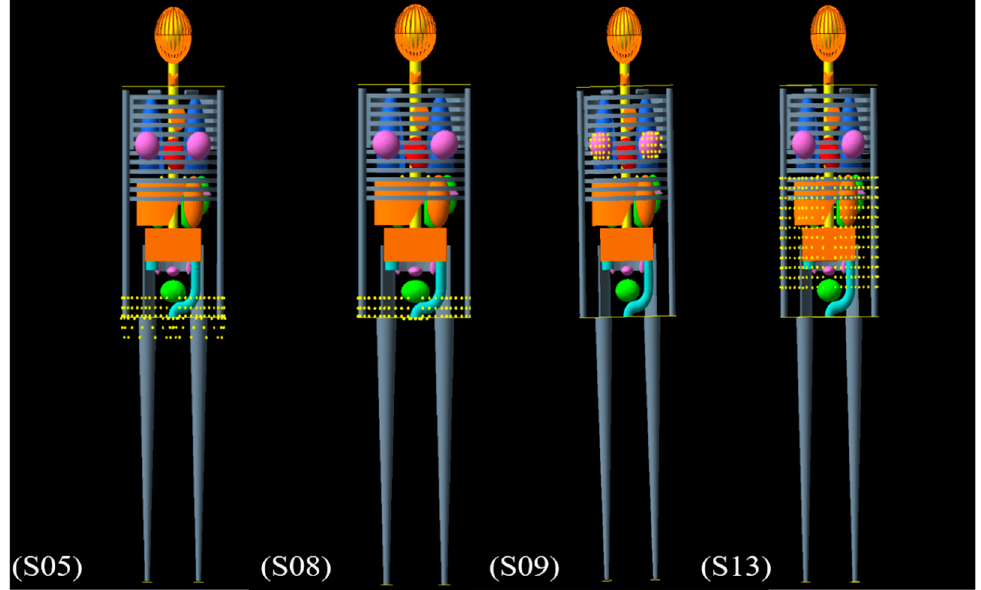
Figure 2. MIRD human phantoms for undergarments, as used in the Geant4 MC simulation; yellow dots represent the undergarment-covered area.